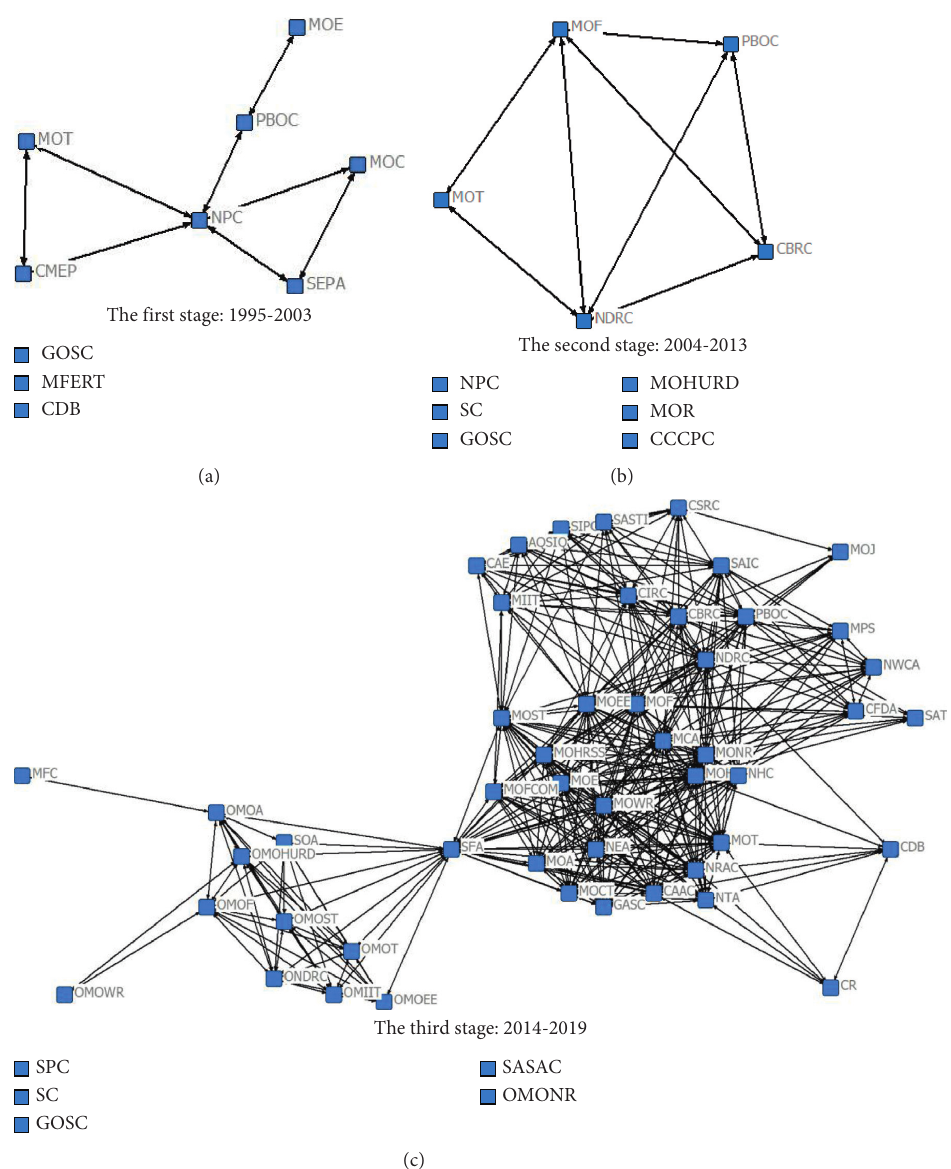
Figure 3: The evolution of PPPs policy entity network in China. (a) The first stage:1995–2003. (b) The second stage: 2004–2013. (c) The third stage: